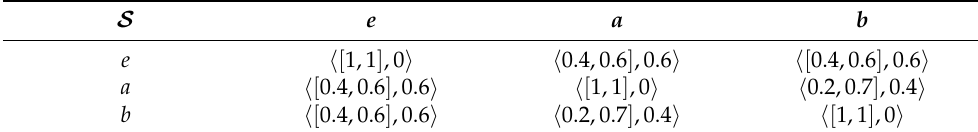
Table 9. The values of the cubic relation S